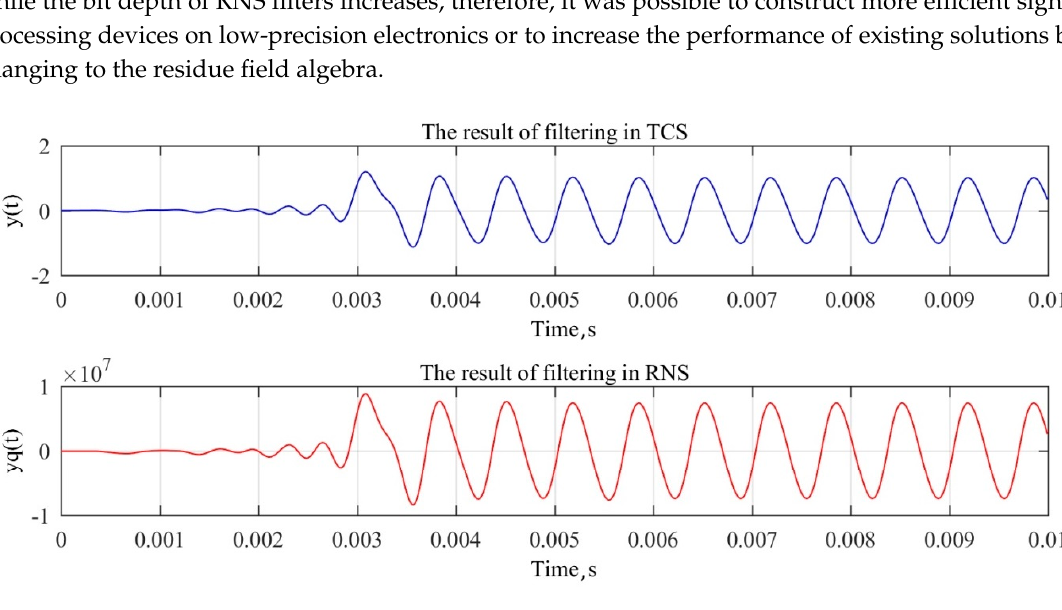
Figure 7. The comparison of filtering error for RNS filter and positional filter.